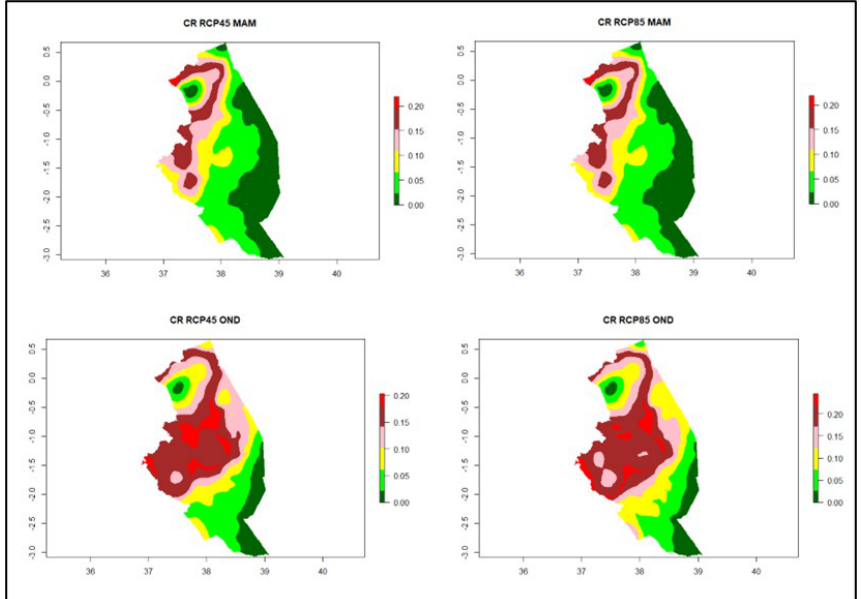
Figure 8. Climate regimes for MAM, OND in 2040 for RCPs 4.5 and 8.5.